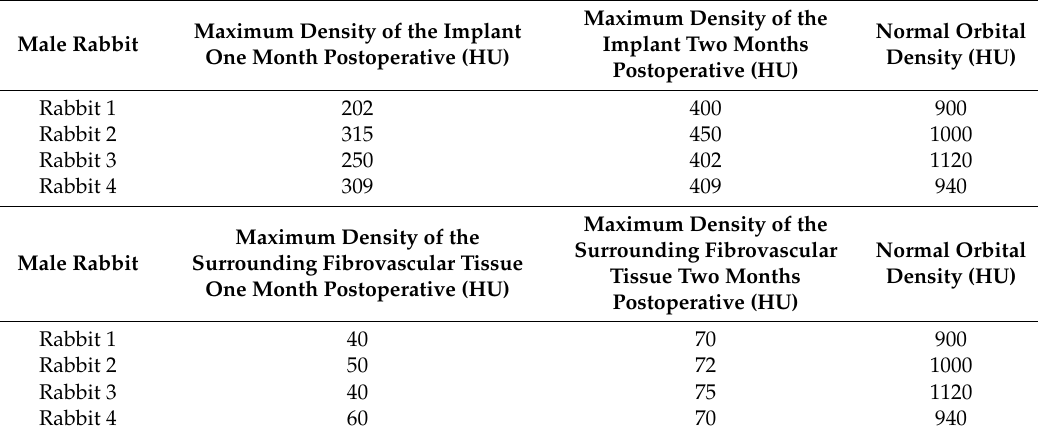
Table 2. Maximum density values in Hounsfield Units (HU) of the implant and surrounding tissues regarding normal orbital osseous density.